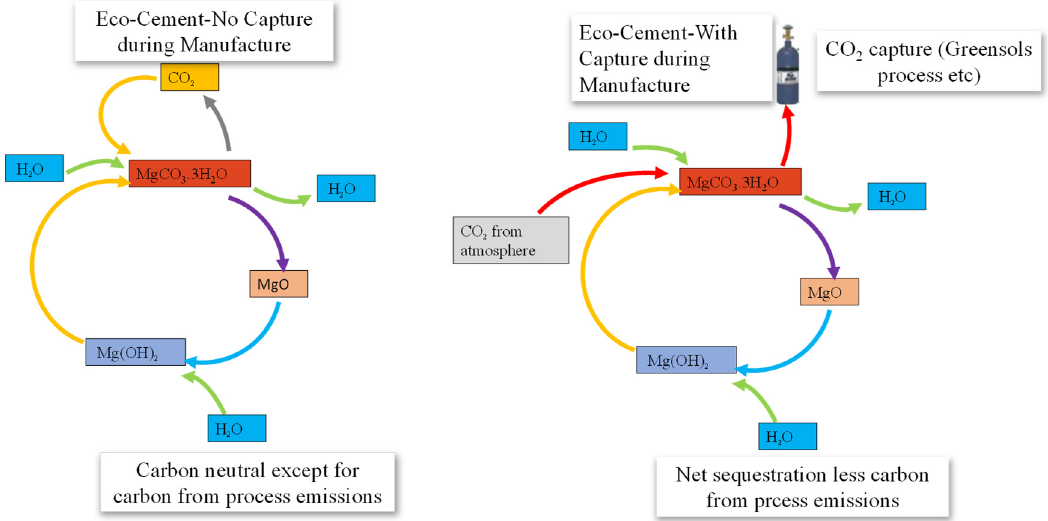
Figure 11. Schematic diagram of MgO and CO 2 cycles [146].